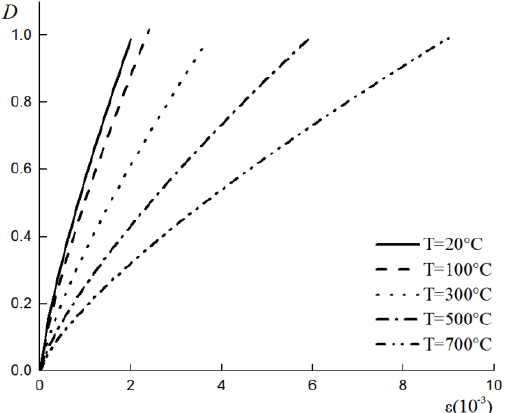
Figure 5. Damage variable vs. strain at different temperatures (C20 concrete).